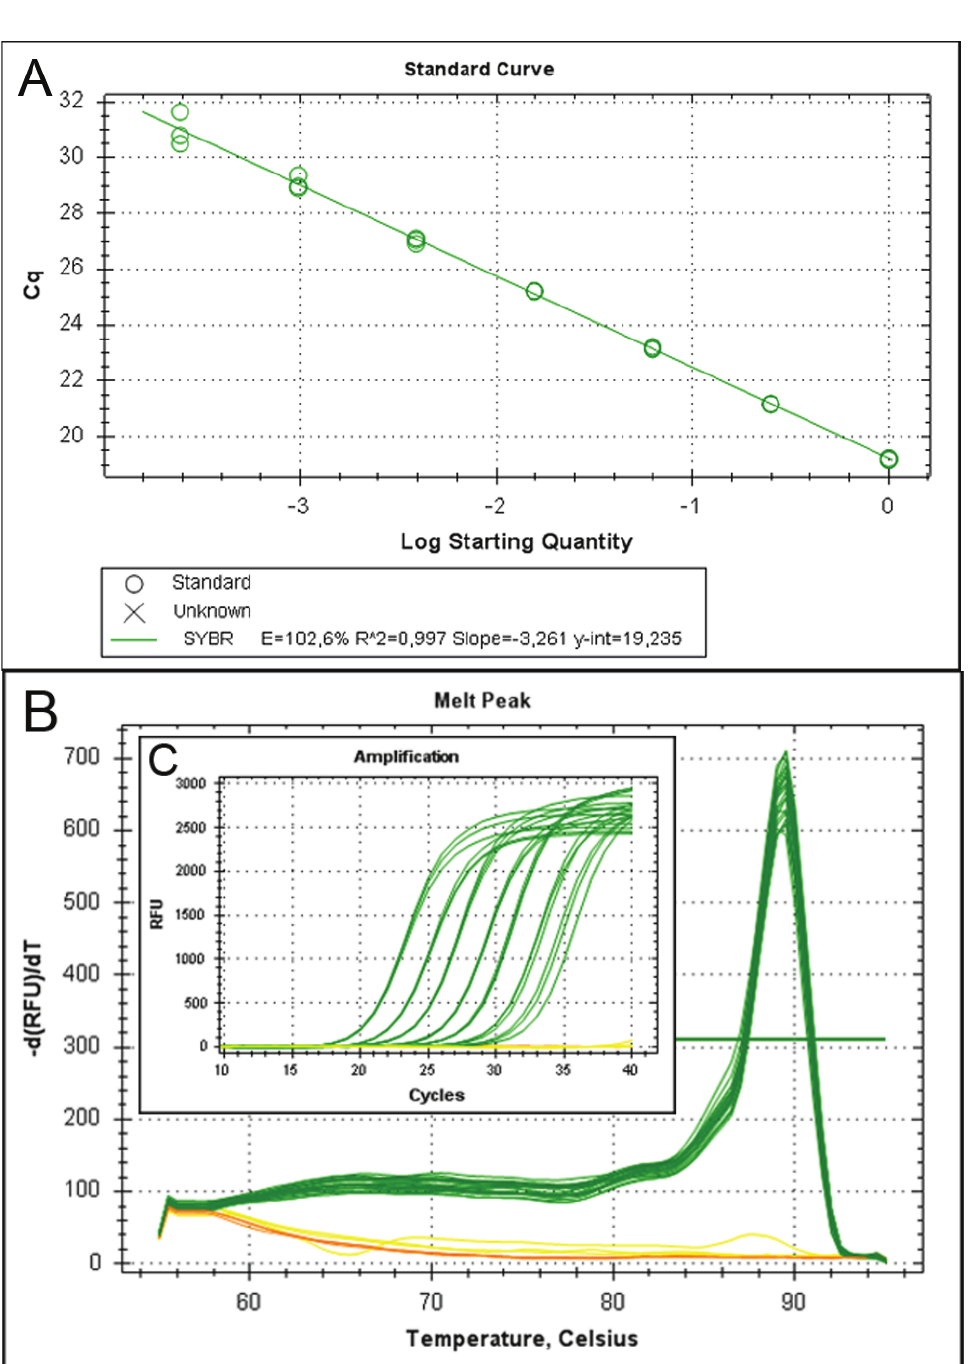
Figure A1. The suitability of the newly designed primers was verified in separate experiments by performing dilution series using the PCR products (Table A2) as well as dilution series of a cDNA pool ( A ). In melt curve ( B ) and amplification plots ( B ) samples are shown in green while controls (no reverse transcription control and no template control) are shown in yellow and orange